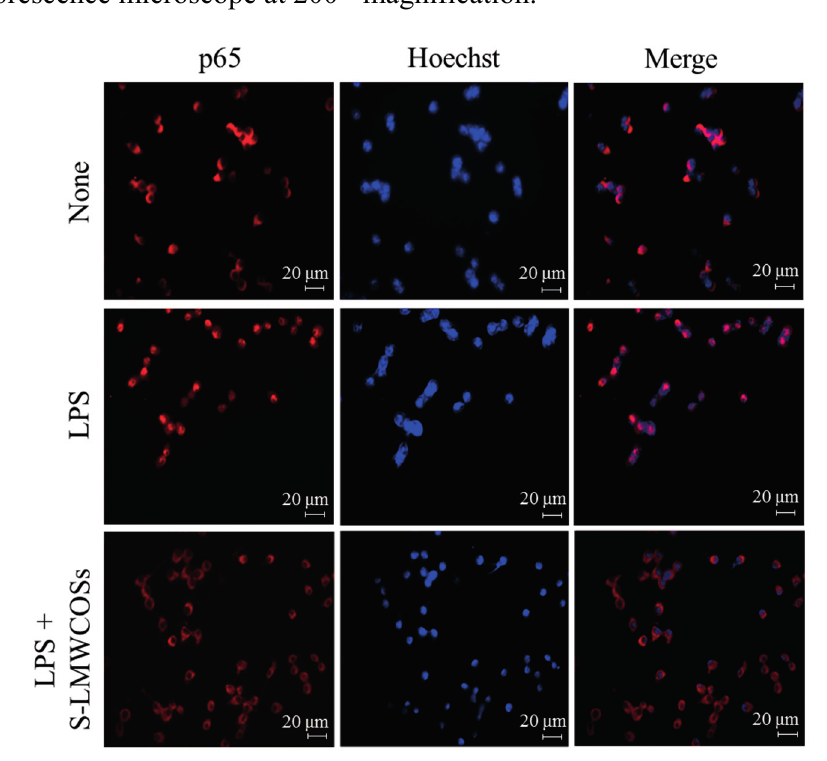
Figure 7. Immunofluorescence staining. The RAW264.7 cells were seeded at the density of 5 × 10 4 cells/well on the 24-well plate. Cells were stimulated with LPS (100 ng/mL) in the absence or presence of S-LMWCOSs (100 μ g/mL) added 1 h before the stimulation. At 30 min after the LPS addition, sub-cellular location of the NF- κ B p65 subunit was determined by immunofluorescence assay. Cells were treated with the indicated dose of using a fluorescence microscope at 200×